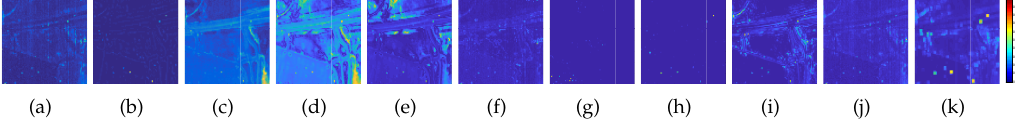
Figure 15. Two-dimensional plots of the detection results obtained by different methods for the Urban dataset. ( a ) GRX; ( b ) BJSRD; ( c ) LSAD; ( d ) LRASR; ( e ) LSMAD; ( f ) CBAD; ( g ) CRD; ( h ) LRX; ( i ) LKRX; ( j ) OSP; and ( k ) BDSLRR.